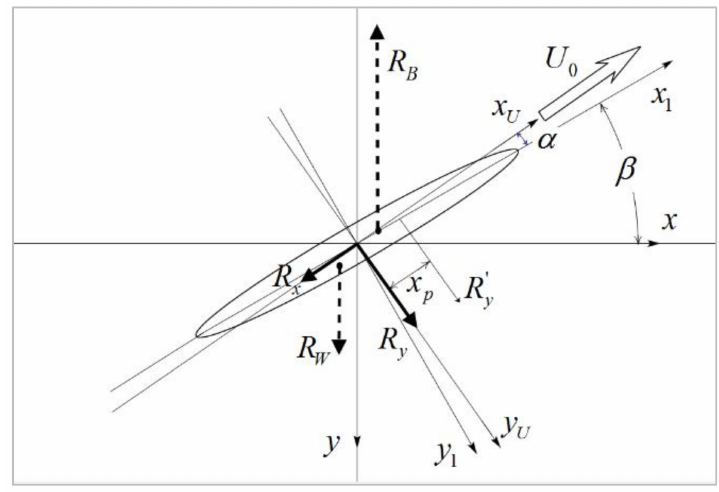
Figure 1. Steady ascent of the underwater glider. Scheme of acting forces.